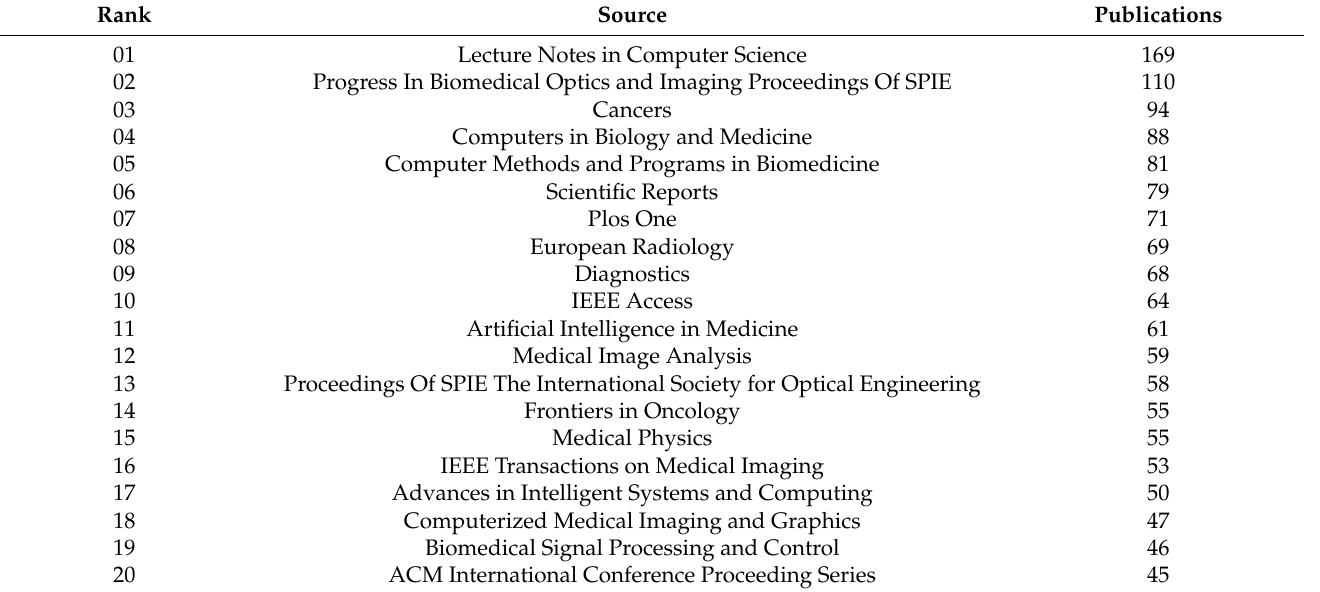
Table 3. Overview of the sources with the most